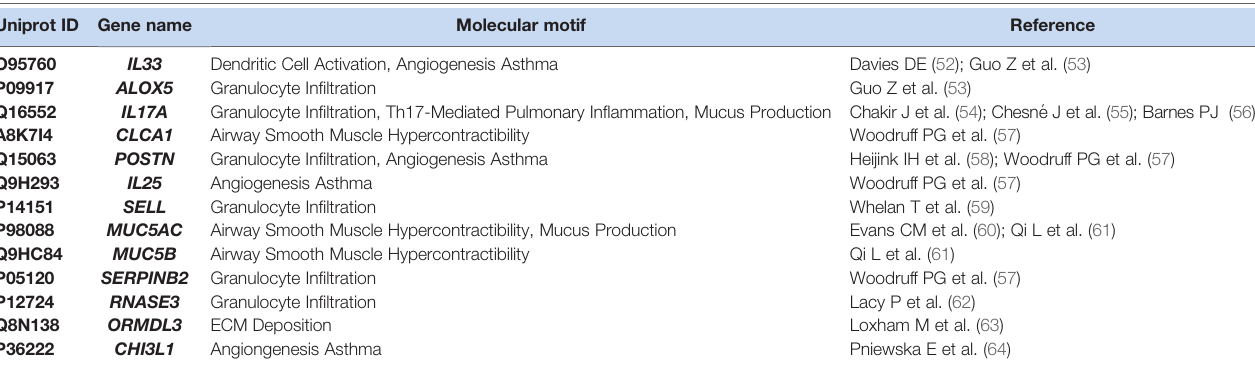
The molecular motifs for which these proteins act as effectors and the corresponding bibliographic reference are also